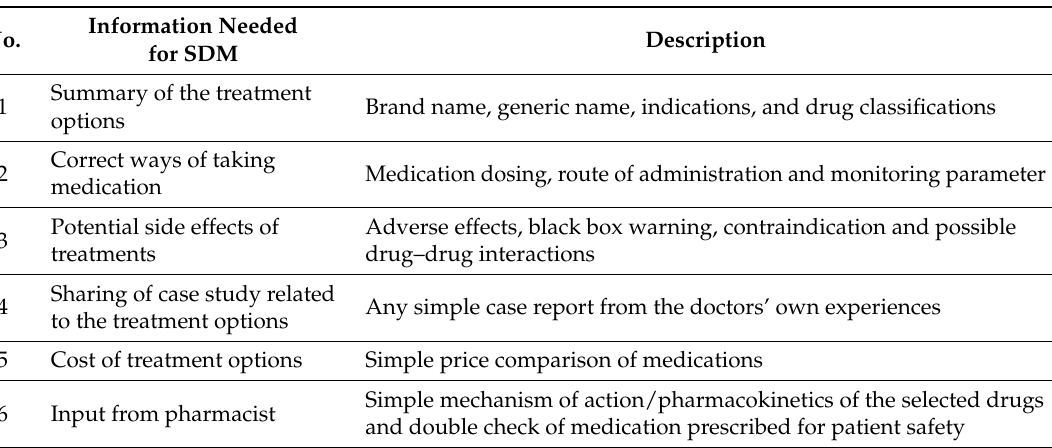
Table 2. Selected information to be included into the strategic